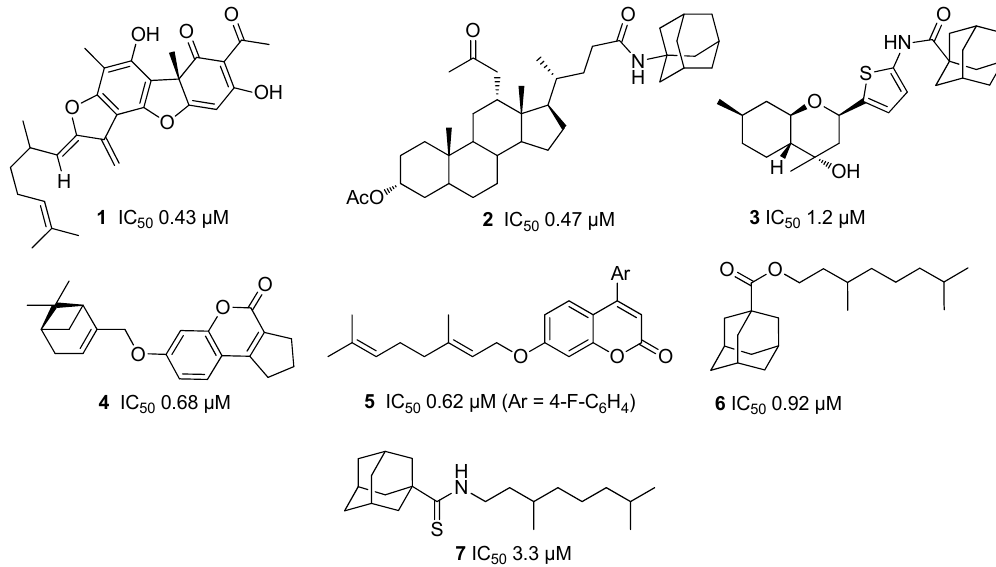
Figure 1. Structures of known TDP1 inhibitors and their half maximal inhibitory concentration (IC 50 ) values.